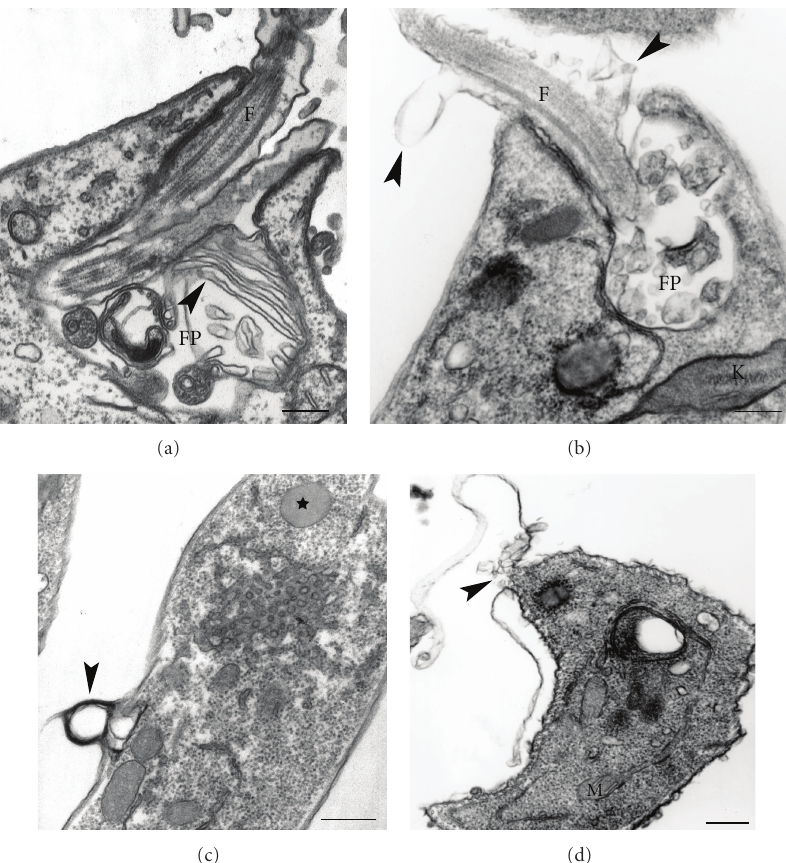
Figure 11: Ultrathin sections of L. amazonensis promastigotes treated with di ff erent sterol biosynthesis inhibitors showing severe alterations in the plasma membrane lining (a) the flagellar pocket, (b) the flagellum, and (c)-(d) the cell body. In (d) it is possible to observe a breakdown in the plasma membrane and release of the subpellicular microtubules ( arrowhead ). Star in (c) shows a classic lipid body. F, flagellum; FP, flagellar pocket; k, kinetoplast; M, mitochondrion. Images are reproduced with permission from [79] (a), and [66] (b), (d) Elsevier. Bars, 0 . 25 μ m (a)–(c) and 0 . 5 μ m